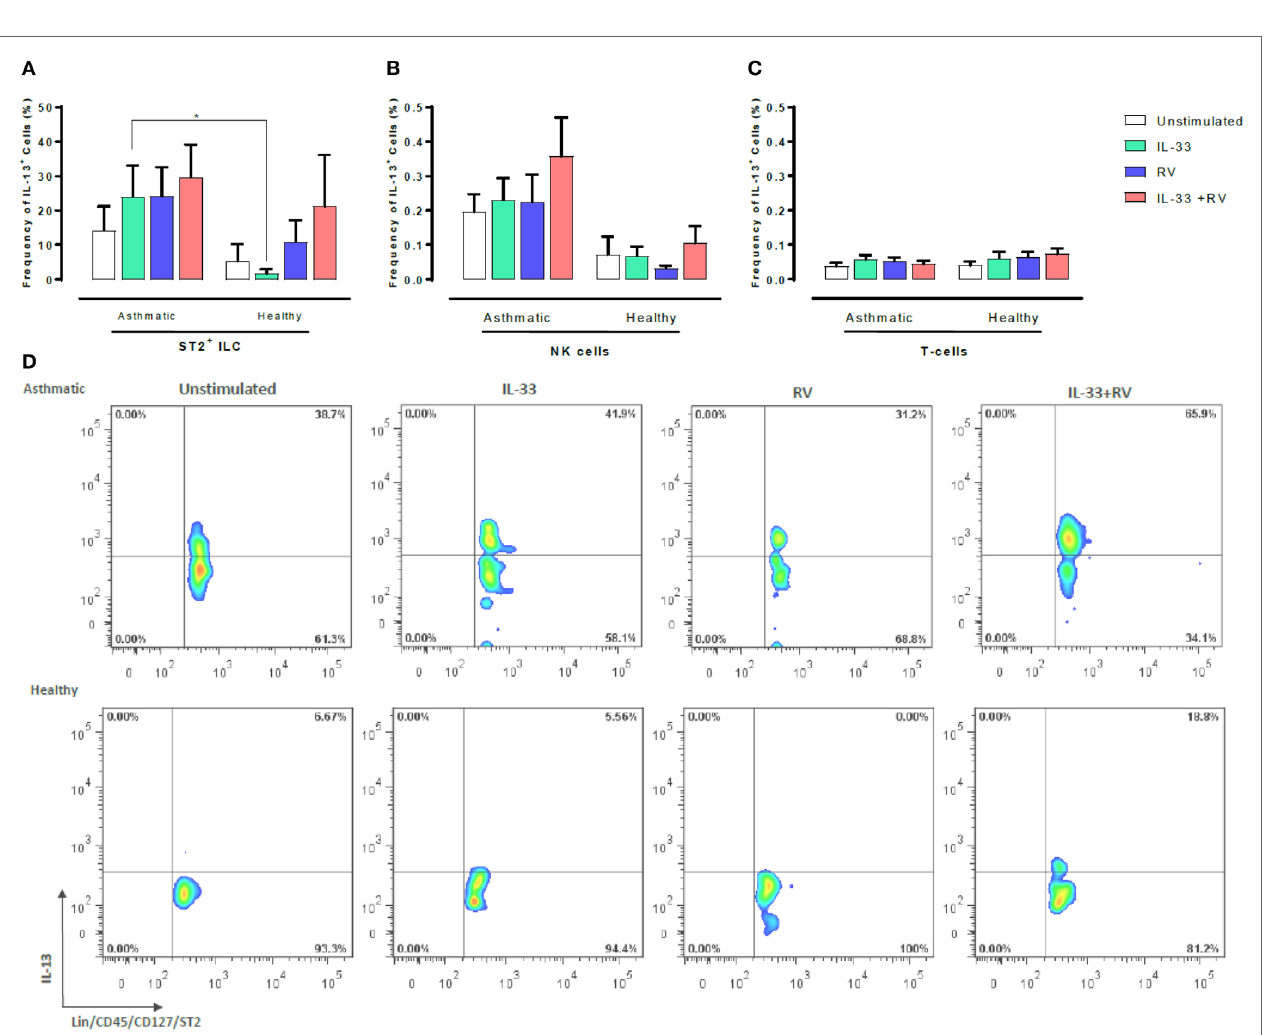
FigUre 3 | Evaluation of IL-13-producing ST2 + ILC, CD56 + , and CD3 + T cells in human PBMC. IL-13-producing cell subsets were evaluated using flow cytometry (a–c) . Raw dot plots representative of IL-13 + ST2 + ILC from 8 asthmatic and 6 healthy donors. PBMCs from people with allergic asthma and non-allergic healthy controls were pre-exposed to media or IL-33 for 6 h and then cultured in the absence or presence of RV for 5 days (D) . Abbreviations: PBMC, peripheral blood mononuclear cells; IL-33, interleukin 33; RV, rhinovirus 16, ST2 + ILCs, ST2 + innate lymphoid cells. * p ≤ 0.05 and ** p ≤ 0.01.